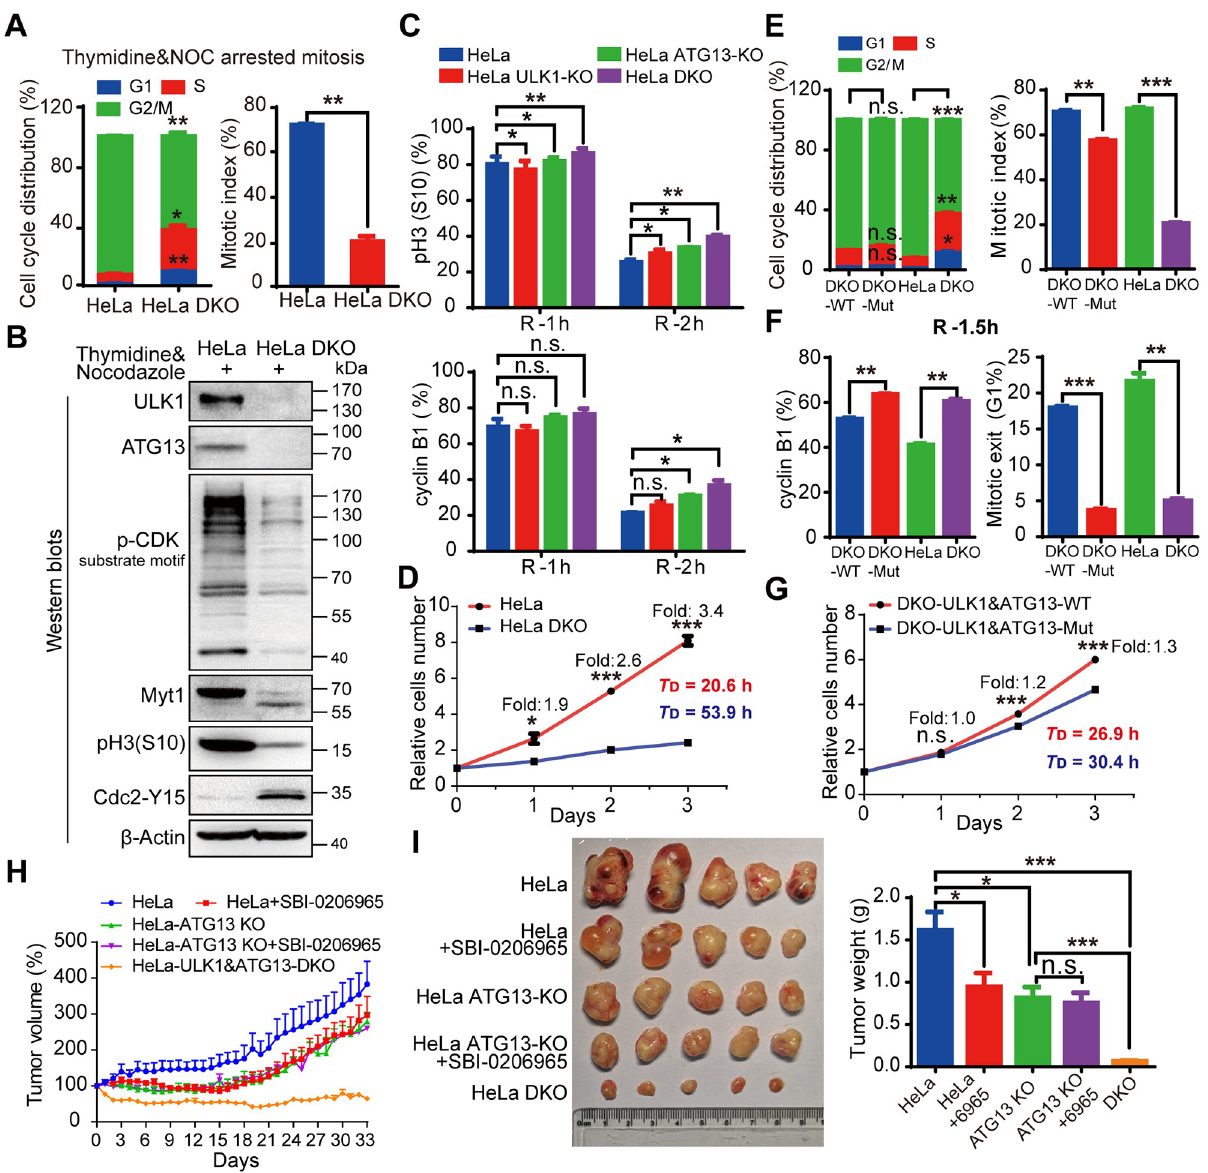
Fig 7. ULK1-ATG13 and their mitotic phospho-regulation by CDK1 are required for cell cycle progression. (A) ULK1-ATG13 DKO inhibits S/G2 and G2/M transitions. HeLa WT or ULK1&ATG13-DKO cells synchronized into mitosis were subjected to PI and pH3(S10) co-staining for cell cycle and mitotic index analysis by flow cytometry. n = 3, � p < 0.05, �� p < 0.01. (B) Representative western blot analysis suggests that ULK1&ATG13 DKO inhibits mitotic entry, which is shown by mitotic markers and CDK1 substrate phosphorylation. (C) Mitotic exit of ULK1, ATG13, or ULK1&ATG13 KO cells. Cells were synchronized into mitosis with thymidine and NOC and released into NOC-free complete DMEM medium for different timepoints and then subjected to either PI and pH3(S10) co-staining or cyclin B1 staining for cell cycle, mitotic index, and cyclin B1 level analysis by flow cytometry. n = 3, � p < 0.05, �� p < 0.01. (D) ULK1&ATG13 DKO inhibits cell proliferation. HeLa WT or ULK1&ATG13 DKO cells were plated at 1 × 10 5 cells/mL and cultured for 1, 2, or 3 days. The cell number was counted by flow cytometry and the doubling time was calculated. T D indicates the average cell doubling time and is calculated as: T D = t � [lg2/(lgNt − lgN0)], where t is the culture time, Nt is the cell number after culturing, and N0 is the original cell number plated. n = 3, � p < 0.05, ��� p < 0.001. (E-G) The role of ULK1-ATG13 phosphorylation in cell cycle progression and cell proliferation. ULK1&ATG13-DKO cells reconstituted with WT mULK1-3FLAG and ATG13-3FLAG or mutant (“Mut”) mULK1-11A and ATG13-4A, HeLa, or ULK1&ATG13-DKO cells were treated as (A)/(B) and (D). The mitotic exit (G1%) is the percentage of cells in G1 phase when released for indicated time. n = 3, �� p < 0.01, ��� p < 0.001. (H) The relative tumor volume growth curve of nude mice bearing different tumors with or without SBI-0206965. The nude mice were injected with cells (1 × 10 7 ) in 100 μ L PBS/Matrigel Matrix (1:1). Seven days postimplantation, 5 mice in each group were injected with 0.5% (M/V) methyl cellulose or SBI-0206965 in 0.5% methyl cellulose (20 mg/kg/d) every day for 33 days. Tumor growth was evaluated every day and tumor volume was calculated as: volume = 1/2 (length × width 2 ). (I) Tumor growth in nude mice bearing WT or KO cells with or without ULK1 kinase inhibitor SBI-0206965. The protocols were indicated as Fig 7H and the mice were sacrificed, and tumors were harvested and